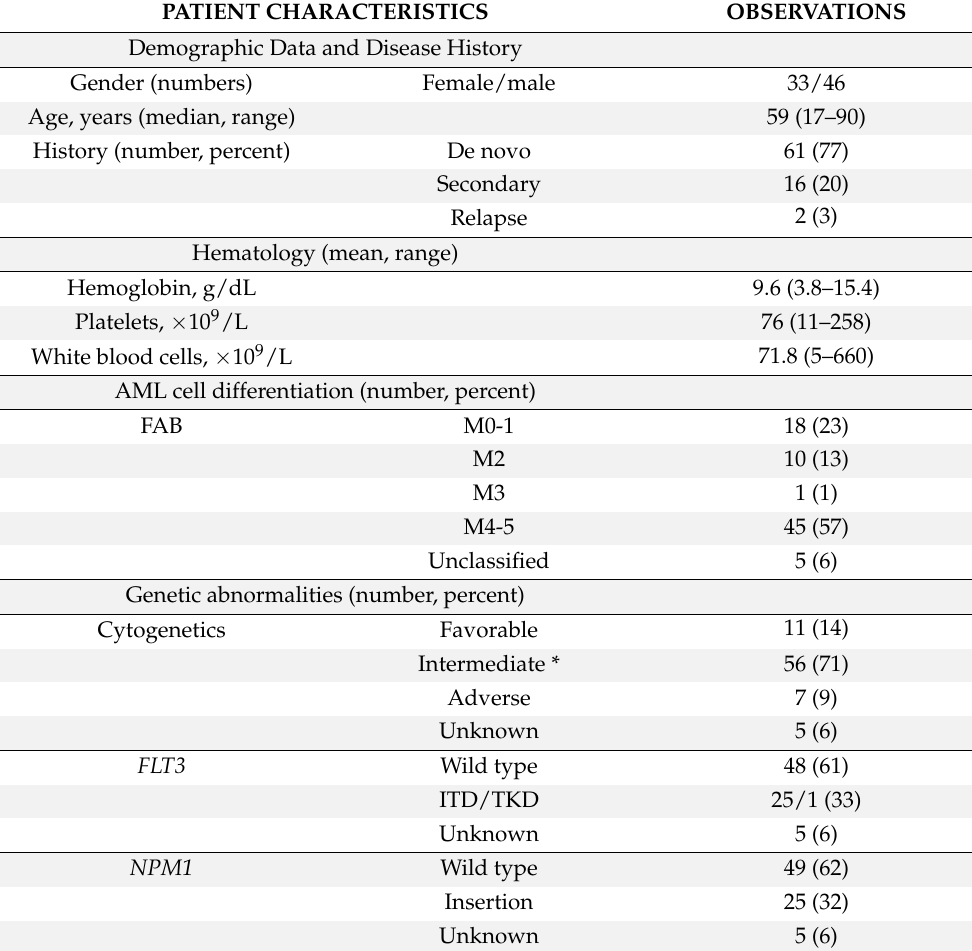
Table 1. Patient characteristics. Demographical and clinical characteristics of the 79 acute myeloid leukemia (AML) patients included in the study. Cytogenetic risk classification is based on the European Leukemia Net classification of 2017 [5]. * Intermediate cytogenetics include normal cytogenetics; 36 samples of the